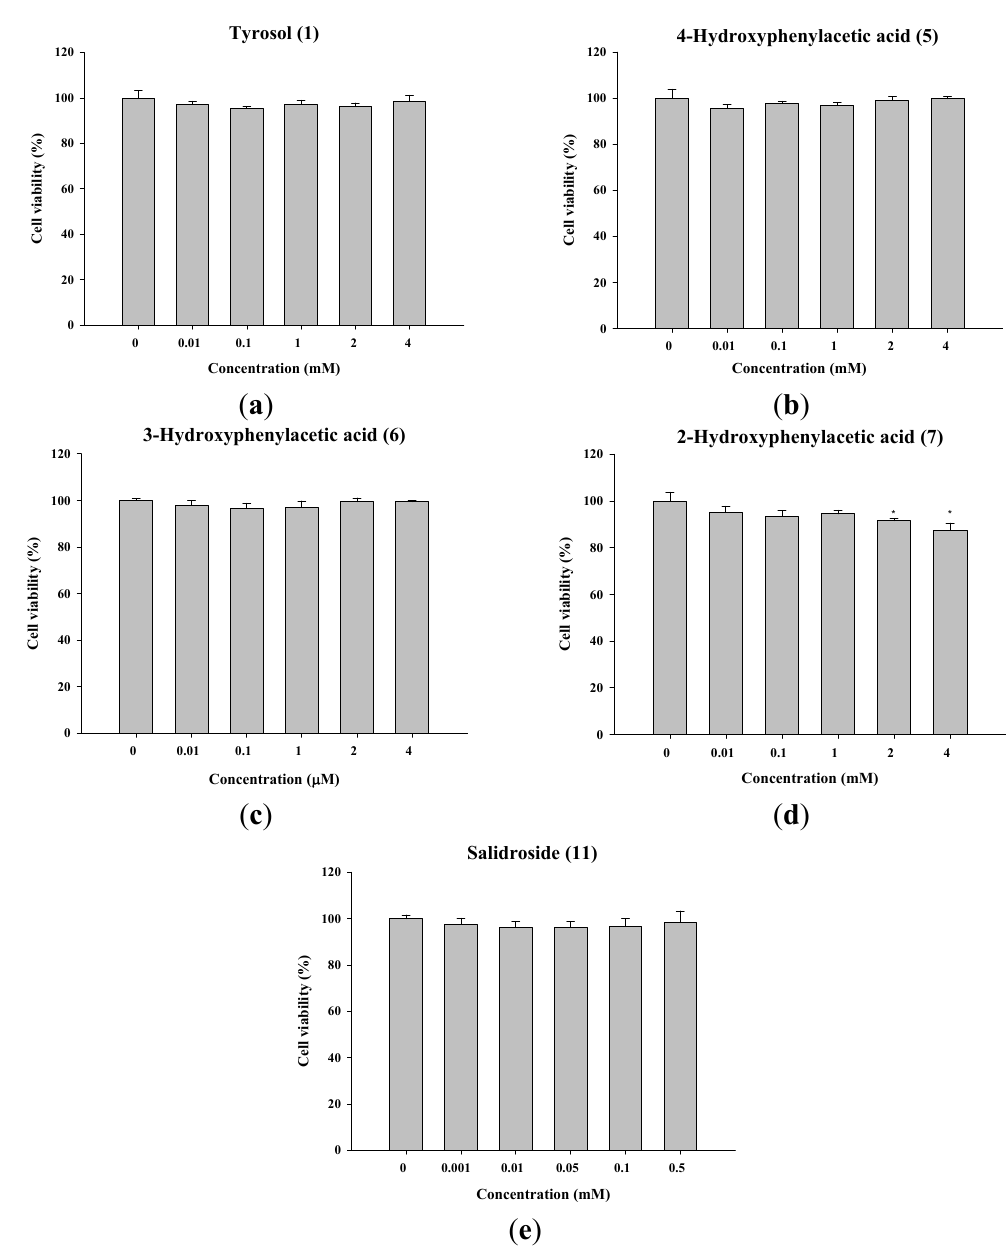
Figure 3. Cell viability (%) of B16 cells exposed to ( a ) tyrosol ( 1 ); ( b ) 4-hydroxyphenylacetic acid (4-HA) ( 5 ); ( c ) 3-hydroxyphenylacetic acid (3-HA) ( 6 ); ( d ) 2-hydroxyphenylacetic acid (2-HA) ( 7 ) and ( e ) salidroside ( 11 ). ( * p < 0.05 vs . Control. Data represent means ± S.D. ( n = 3)). Tyrosol (1)